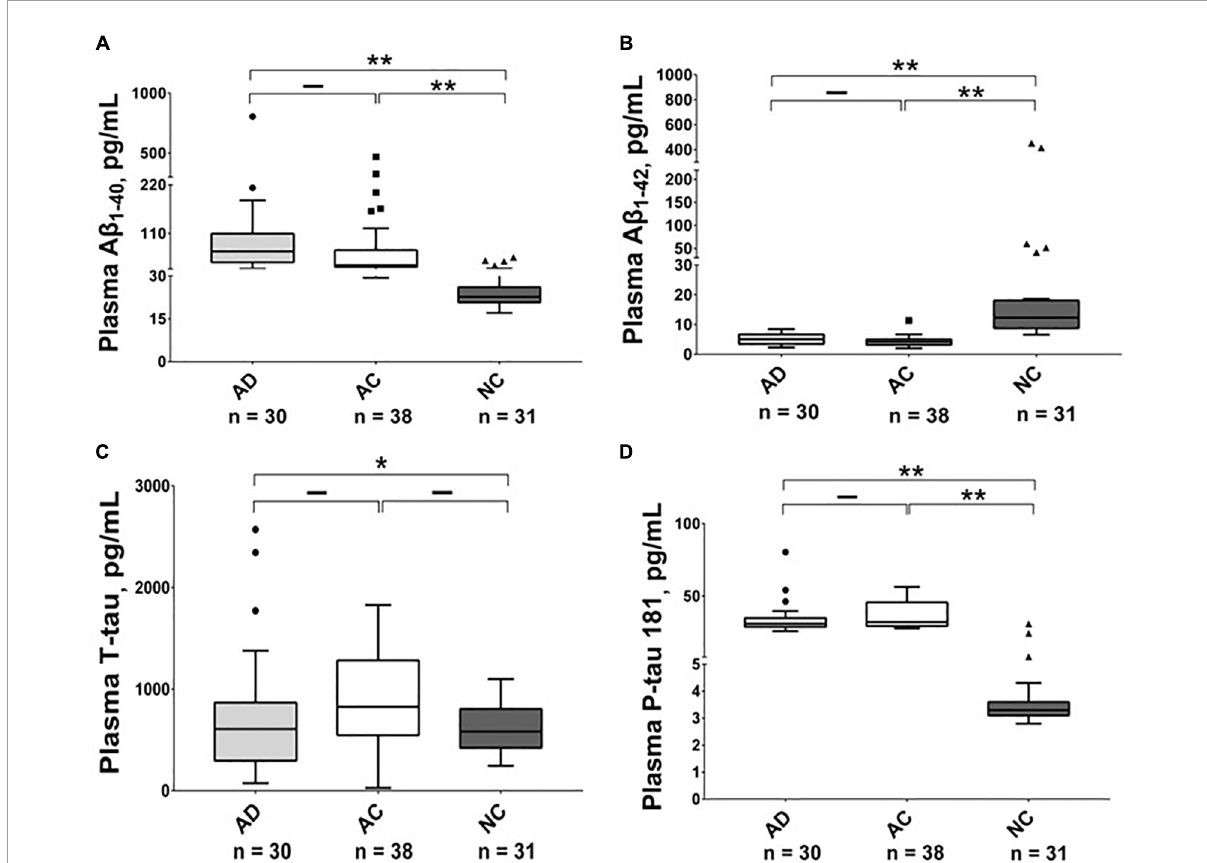
FIGURE1 Plasma level of A β 1 - 40 , A β 1 - 42 , T-tau and P-tau 181 in different groups. The plasma concentrations of (A) A β 1 - 40 , (B) A β 1 - 42 , (C) T-tau and (D) P-tau 181 in Alzheimer’s disease (AD), adult children (AC) and non-demented control (NC) groups were compared using the Kruskal–Wallis tests. Plasma A β 1 - 42 levels were lower in the AD and AC groups compared with the NC group, while P-tau 181 levels were higher. The boxes show interquartile range, the horizontal lines are medians and the whiskers were plotted using the Tukey method. * p < 0.05, ** p <